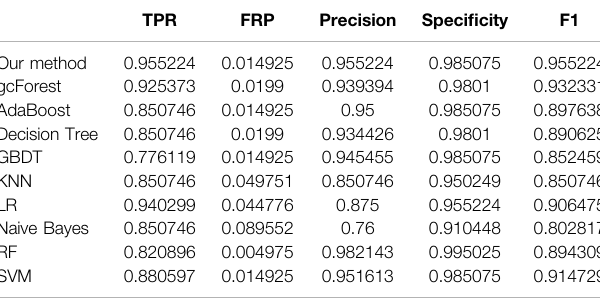
TABLE 2 | Classi fi cation performances of ten methods with 4-cross validation methods. TPR FRP Precision Speci fi city F1